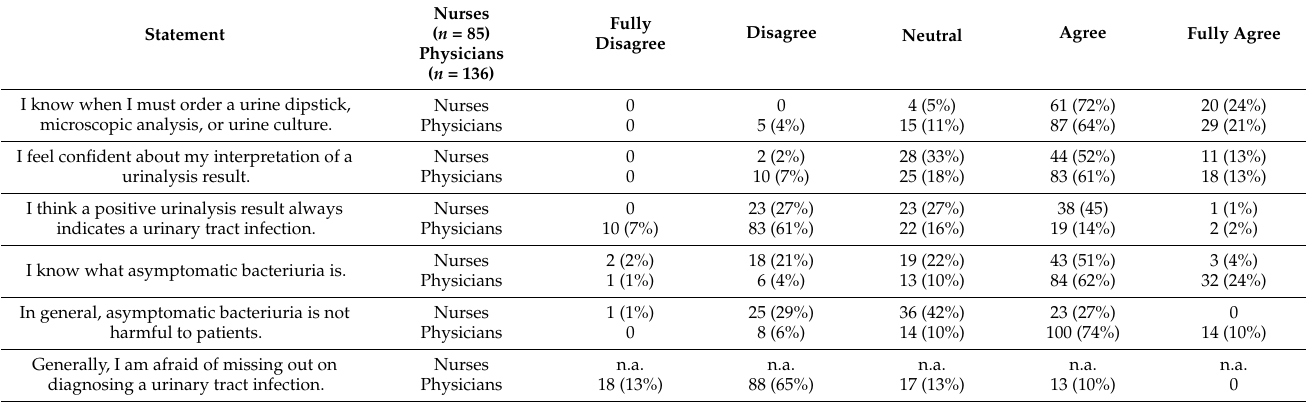
Table 2. Healthcare workers’ knowledge about urine testing.